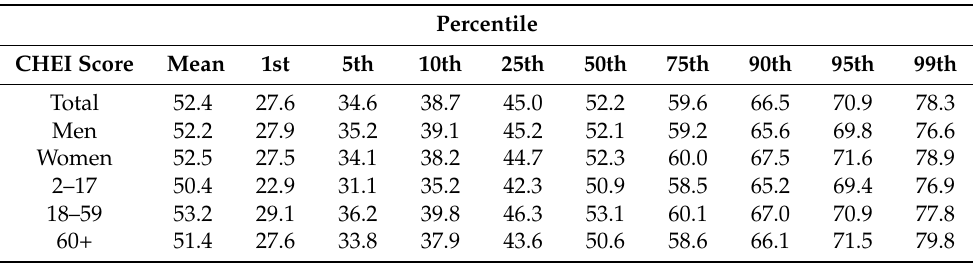
Table 5. Estimated mean and percentiles of the CHEI in 14,584 participants from CHNS-2011, based on three days of dietary